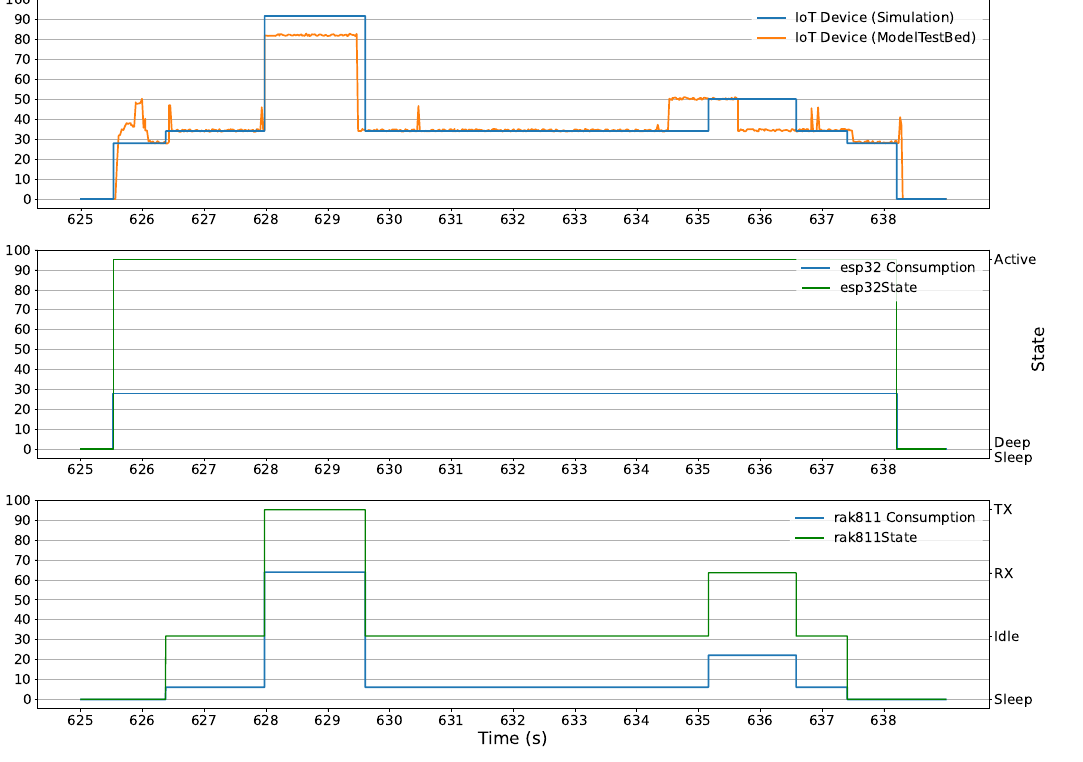
Figure 21. Energy trace generated by the UC 2 E tool. The upper part shows the total current consump- tion of the system as a comparison between the IPA (blue line) and DPA with ModelTestBed execution (orange line). Diagrams in the middle and lower parts show the expected current consumption (blue line) and state (green line) of the ESP32 and RAK811. The results of the BME280 have been omitted due to their negligible